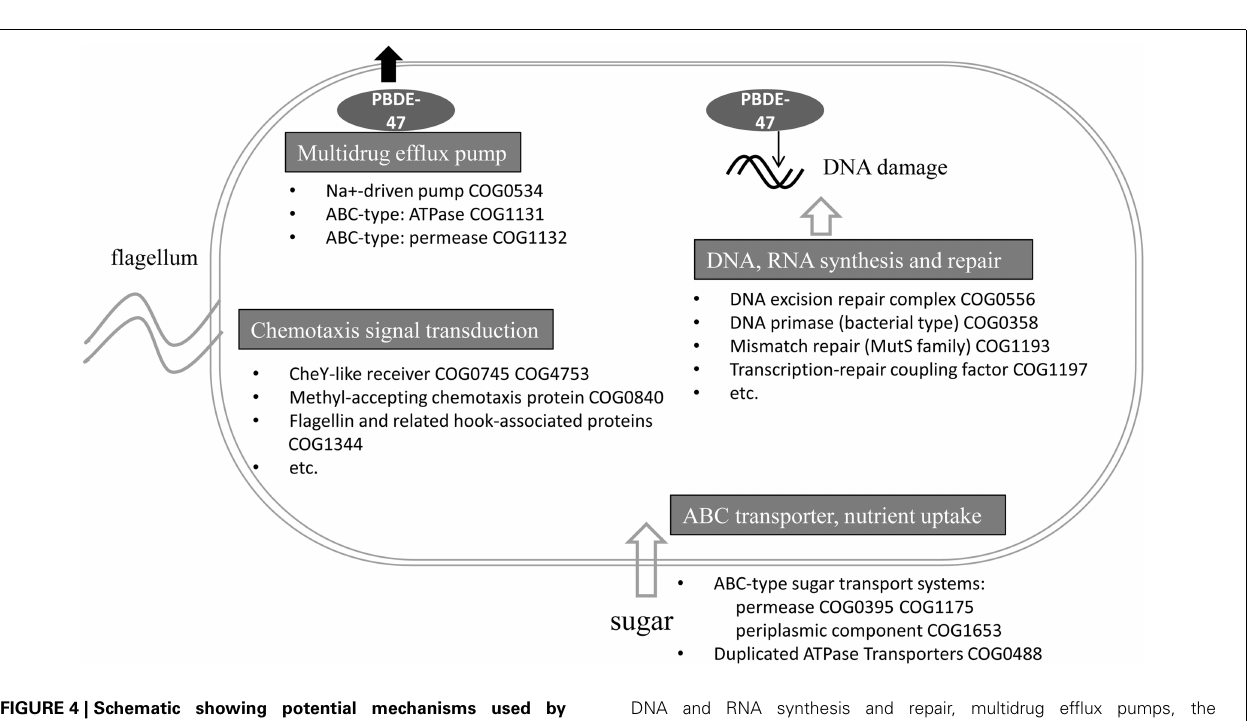
FIGURE 4 | Schematic showing potential mechanisms used by the bacterial community to survive the stress caused by PBDE-47. Functional genes (with the COG number) involved in